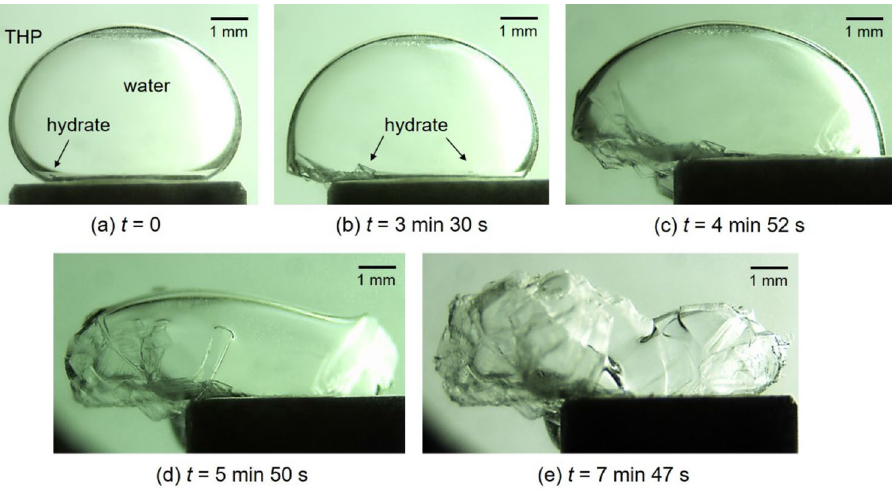
Figure 2. Sequential images of H 2 + CO 2 + THP hydrate growing on a water droplet at T ex = 283.0 K, Δ T sub = 2.5 K, P = 5.00 MPa. The gas composition was H 2 :CO 2 = 0.55:0.45 in mole fraction. The elapsed time after the hydrate nucleation is indicated below each image.